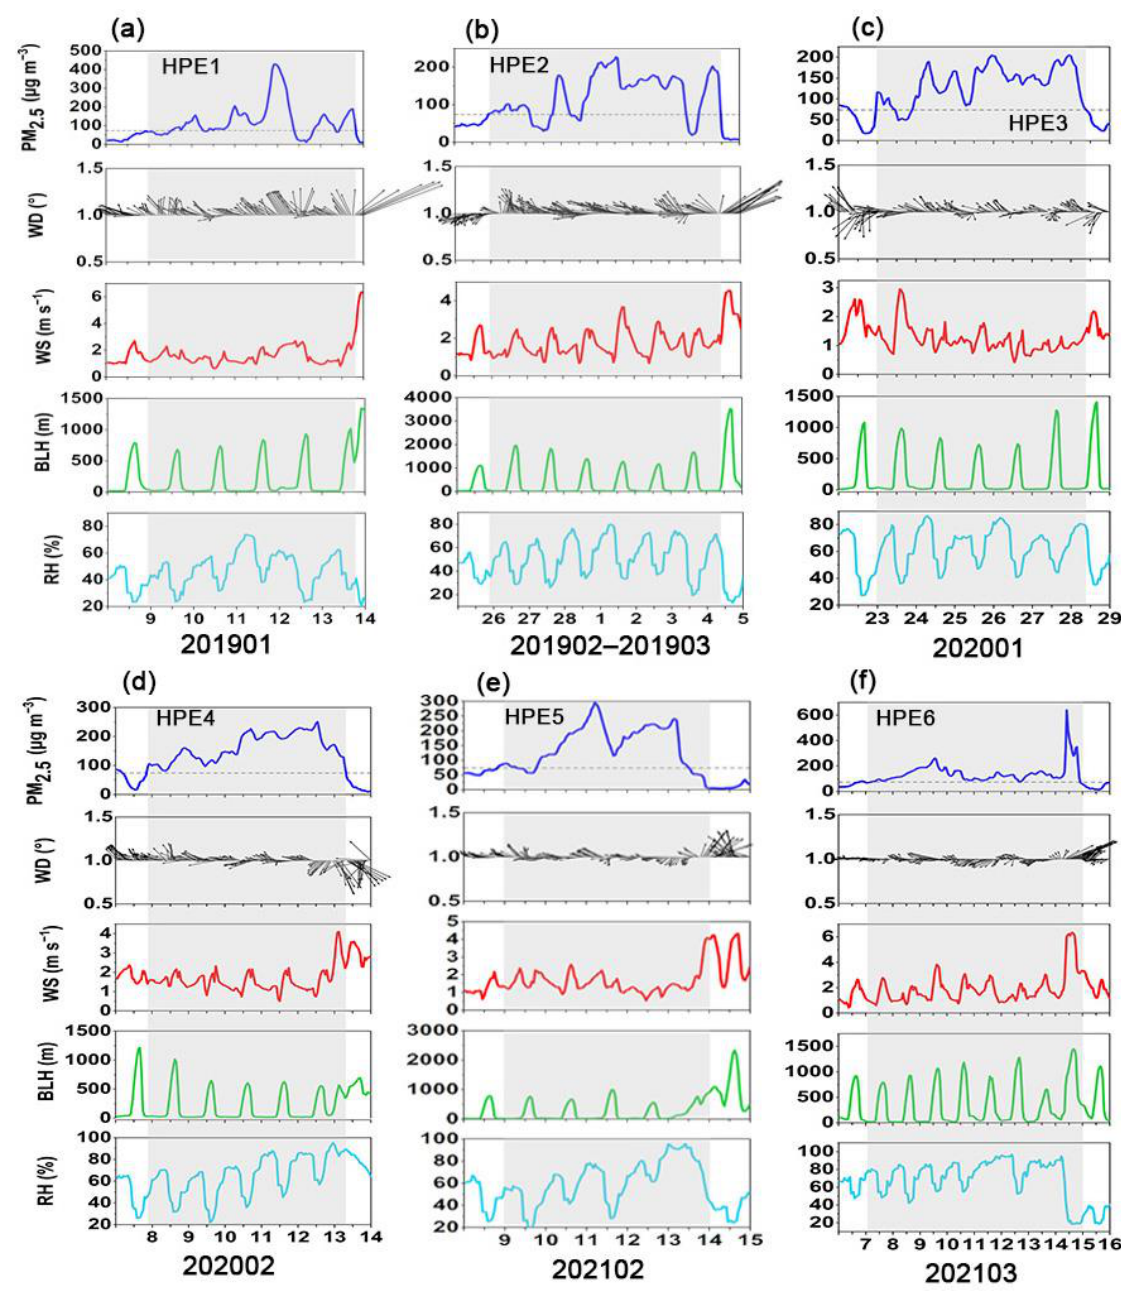
Figure 4. Time series of PM 2.5 concentrations, wind direction (WD), wind speed (WS), boundary layer height (BLH), and relative humidity (RH) during six heavy PM 2.5 pollution episodes (HPEs) in Beijing. ( a ) HPE1, ( b ) HPE2, ( c ) HPE3, ( d ) HPE4, ( e ) HPE5, and ( f ) HPE6.